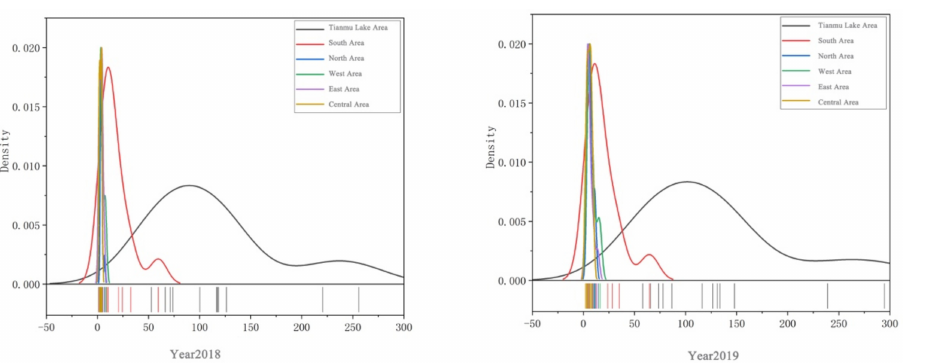
Figure 11. Monthly distribution characteristics of regional tourism flows. Table 10. List of off-peak and peak seasons tourism numbers by region in Liyang in 2018–2019.